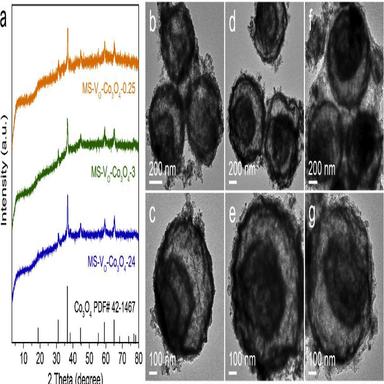
(a) XRD patterns and TEM images of (b,c) MS-VO-Co3O4-0.25, (d,e) MS-VO-Co3O4-3 and (f,g) MS-VO-Co3O4-24.